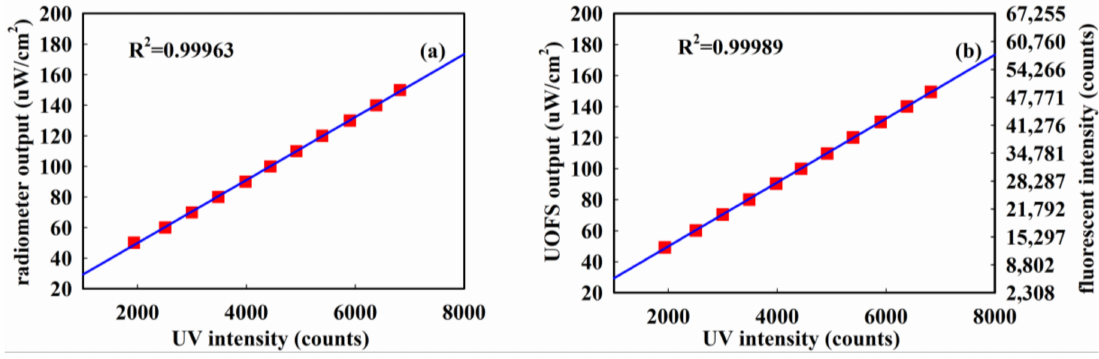
Figure 14. The comparison of the ( a ) ultraviolet radiometer and ( b )